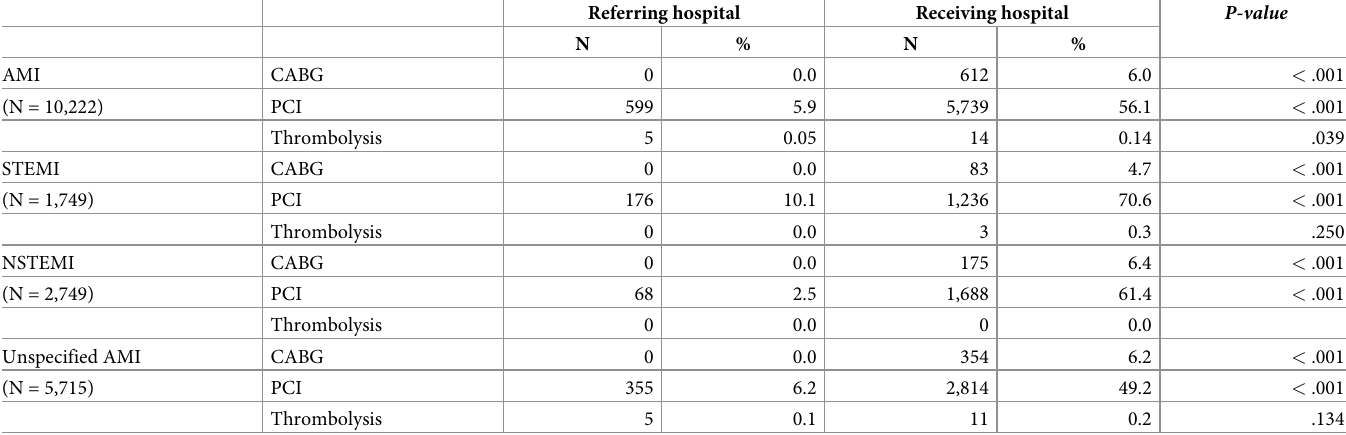
Table 6. Procedures provided for patients with acute myocardial infarction before and after inter-hospital